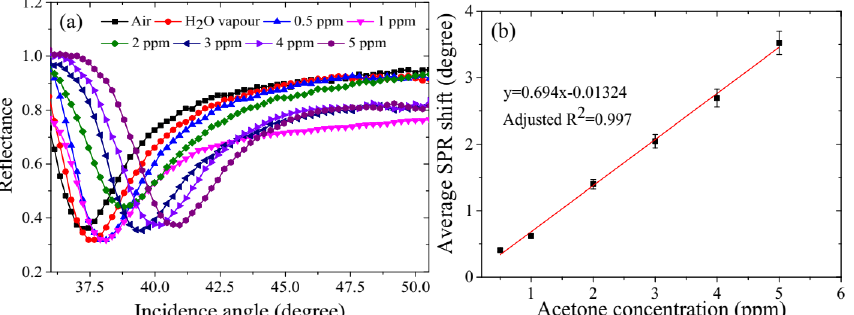
Figure 6. ( a ) Variation of SPR angle due to exposure of the SPR sensor to air, water vapour and various concentrations of acetone vapour from 0.5 ppm to 5 ppm, and ( b ) average SPR angle shift versus acetone concentration (0.5 ppm–5